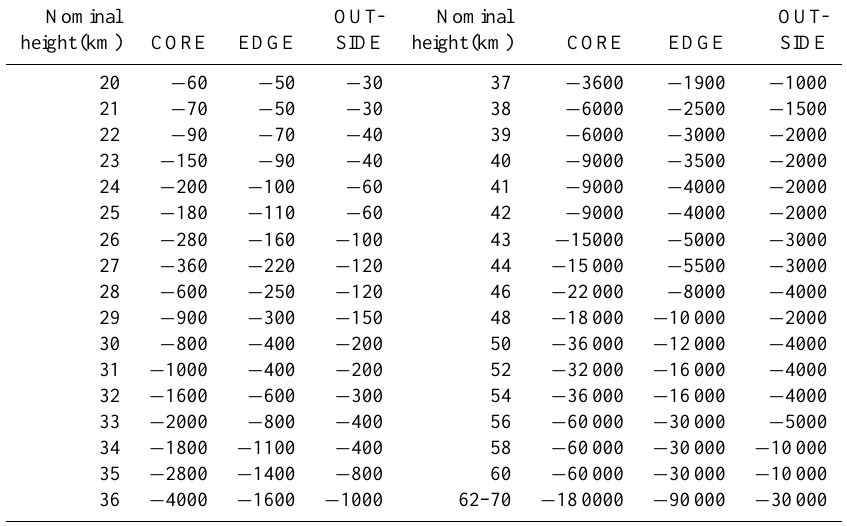
Table 1. Limits, derived from the potential vorticity (10 − 6 Km 2 s − 1 kg − 1 ) , of the southern hemispheric regions CORE, EDGE, and OUT- SIDE at the individual heights. The altitudes are adapted from the MIPAS retrieval grid and the shown potential vorticity values hold for 2002–2011.